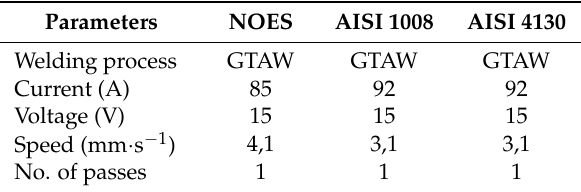
Figure 1. Dimensions of the ( a ) non-oriented electrical steel (NOES); ( b ) low carbon hypoeutectoid steel (AISI) 1008 and low alloyed hypoeutectoid steel (AISI) 4130 welded samples. (WD: Welding direction, RD: Rolling Direction). Table 3. Welding parameters for weld